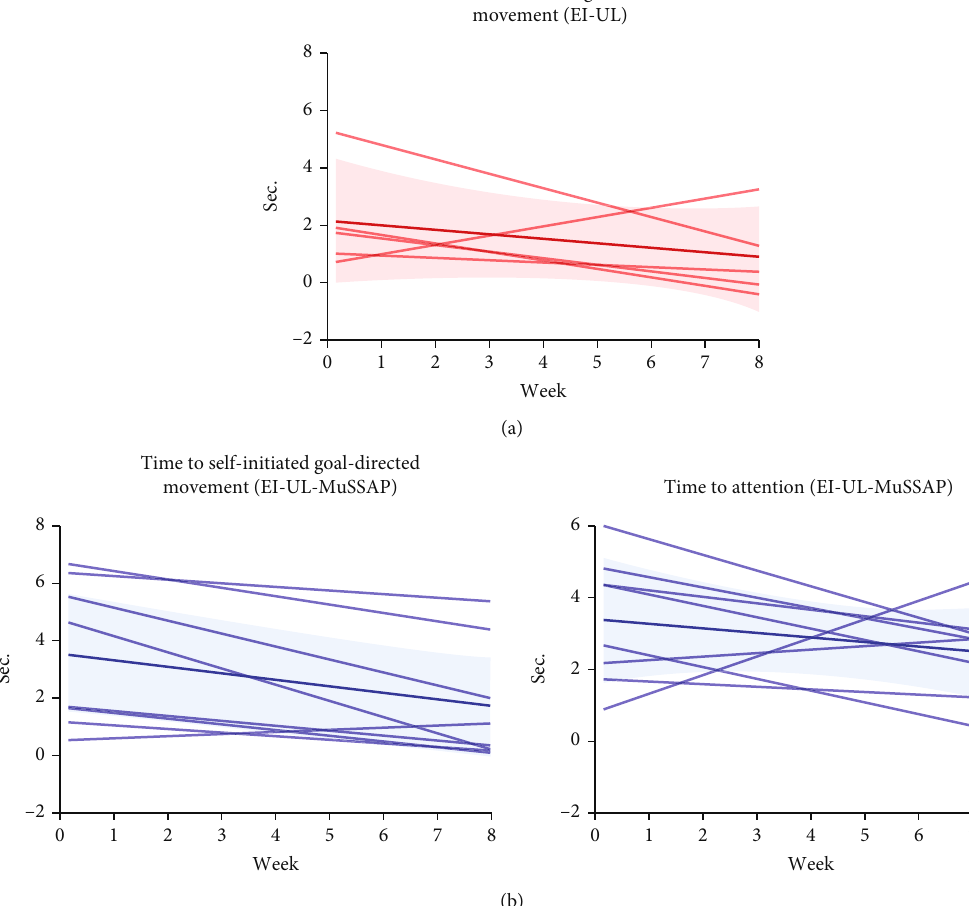
Figure 5: (a) Linear regression lines time to self-initiated goal-directed movement for infants receiving EI-UL (individual and group + SD). (b) Linear regression lines time to self-initiated goal-directed movement and time to attention for infants receiving EI-UL – MuSSAP training (individual and group +